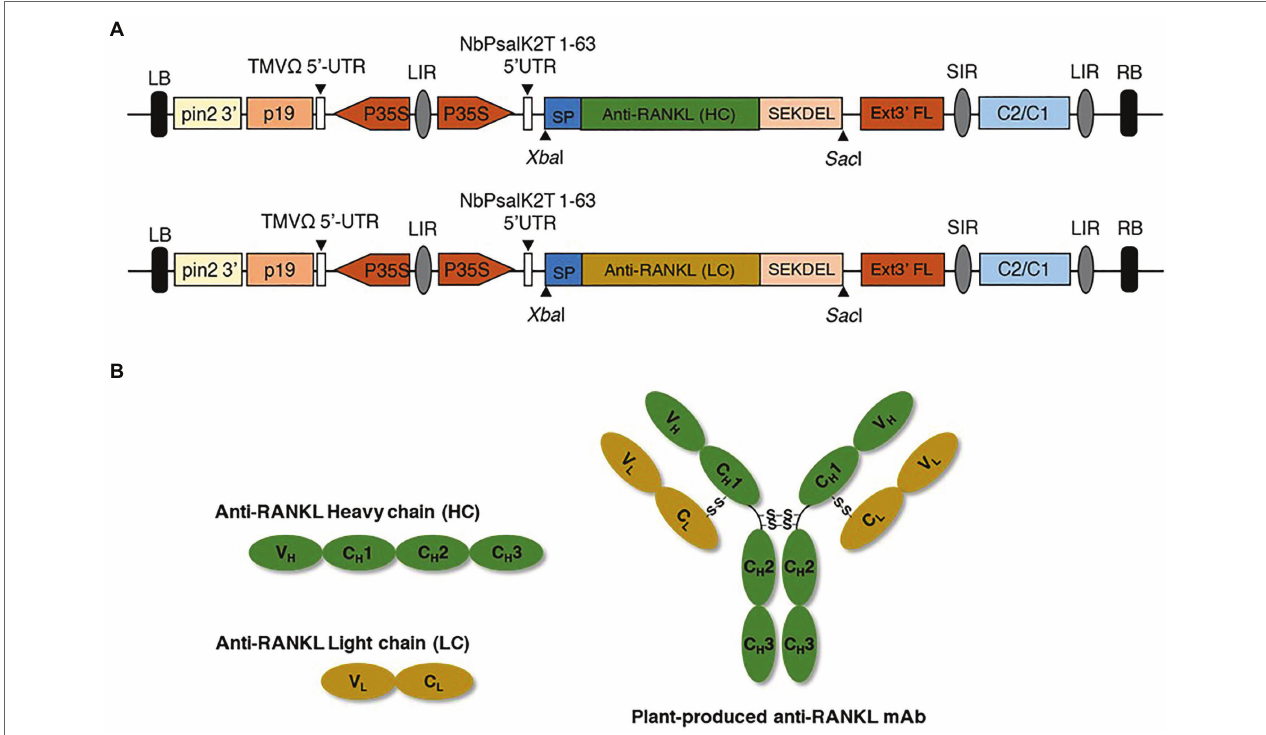
FIGURE 2 | (A) Schematic representation of the geminiviral expression vector. P35S, Cauliflower mosaic virus (CaMV) 35S promoter; TMV Ω 5 ' -UTR, tobacco mosaic virus Ω 5 ' untranslated region; anti-RANKL mAb gene, anti-receptor activator of nuclear factor Kappa-B ligand monoclonal antibody; HC and LC, heavy and light chains of the antibody; SP, signal peptide; SEKDEL, C-terminal endoplasmic reticulum (ER) retention signal peptide; Ext3 ' FL, 3 ' full length of the tobacco extension gene; C2/C1, C1 and C2 gene of Bean Yellow Dwarf virus (BeYDV) for replication initiation protein (Rep) and RepA; p19, p19 gene from Tomato Bushy Stunt Virus (TBSV); LIR, long intergenic region of BeYDV genome; SIR, short intergenic region of BeYDV genome; LB and RB, left and right borders of the Agrobacterium . (B) Schematic and structural elements of heavy chain (HC), light chain (LC), and assembled plant-produced anti-RANKL